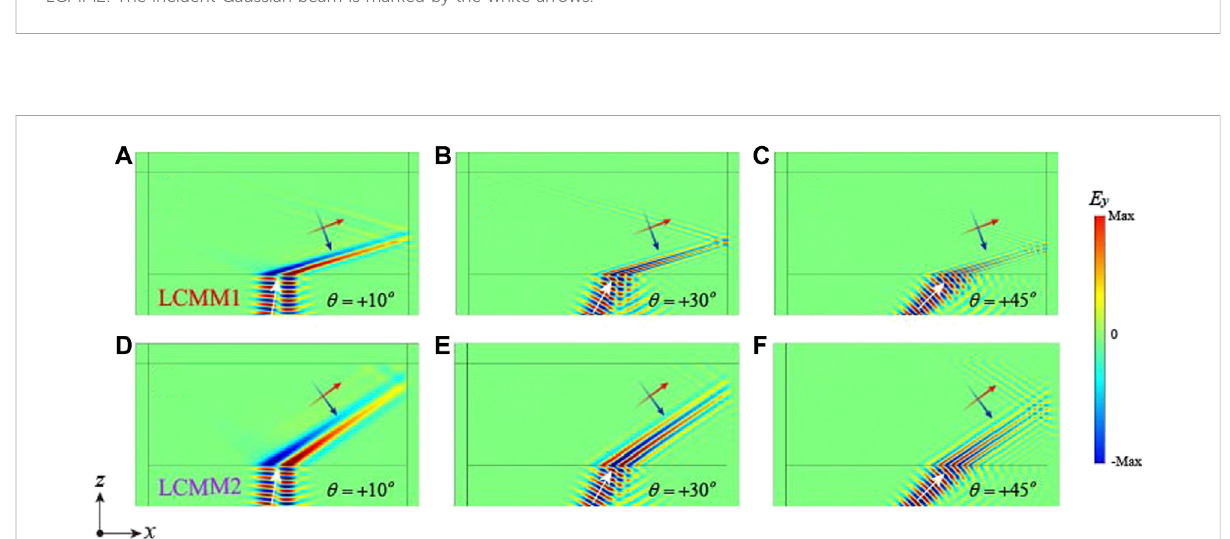
FIGURE 4 DirectionalrefractionoftheMLCMMbasedontheDrude-Lorenzmodel. (A – C)